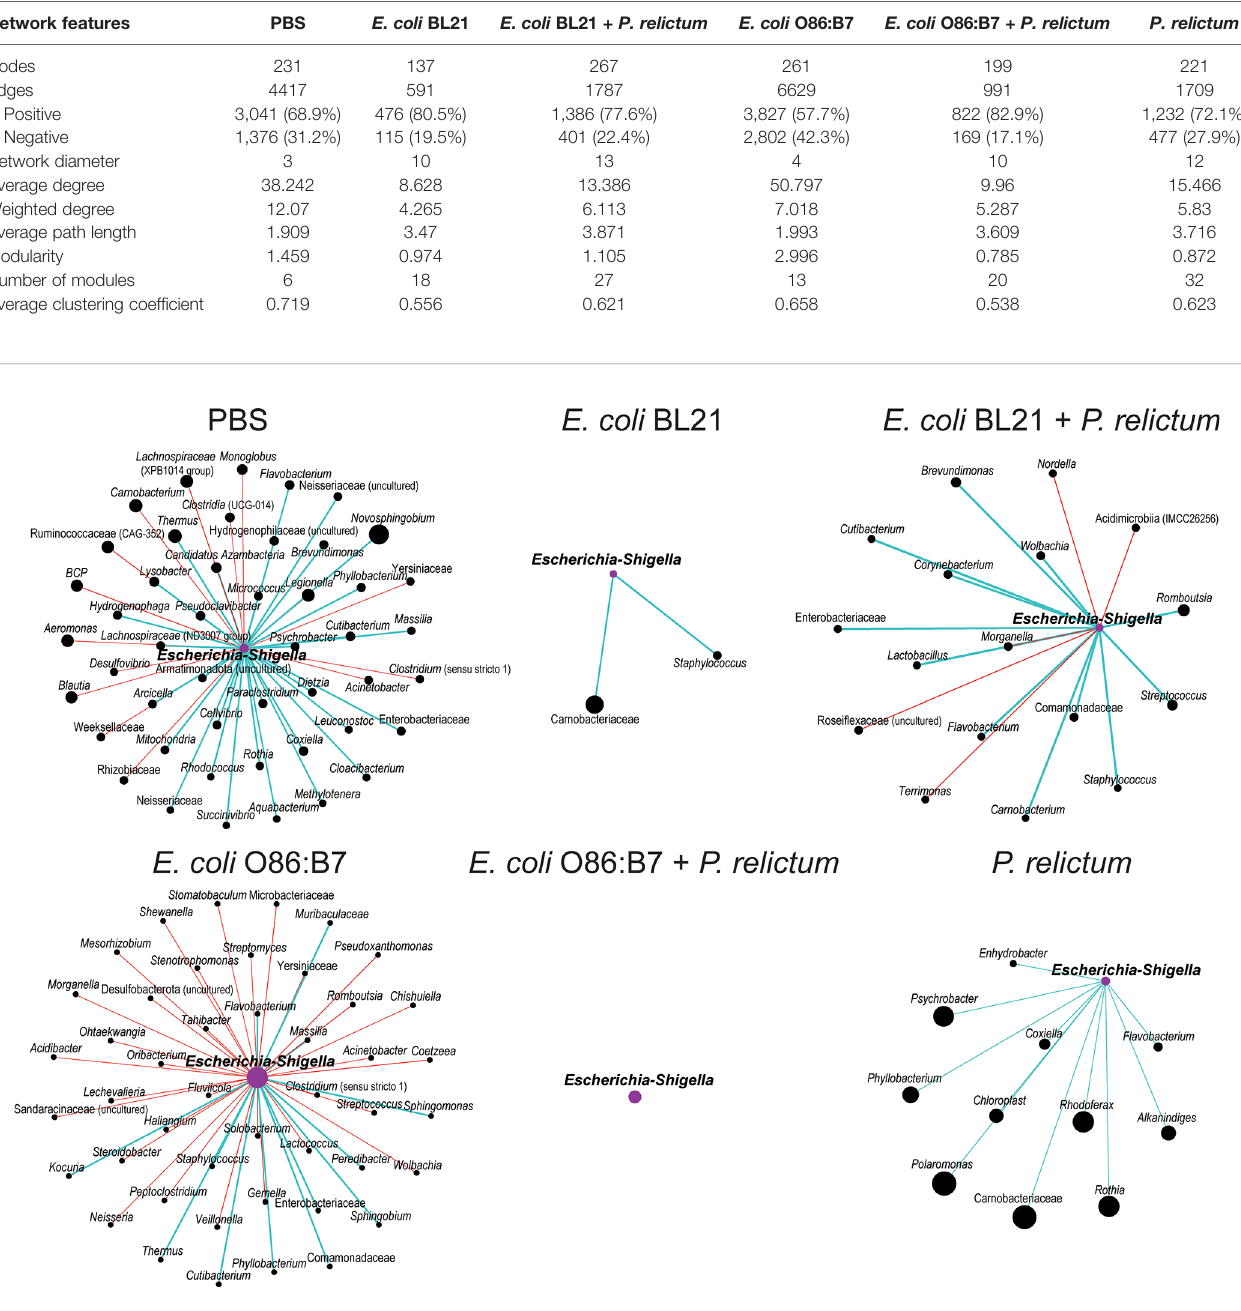
FIGURE 7 | Local connectivity of Escherichia-Shigella in the co-occurrence networks of C. quinquefasciatus microbiota in the different experimental groups. The nodes/taxa linked to Escherichia - Shigella (purple node) were identi fi ed in the bacterial co-occurrence networks of mosquitoes fed on mock-immunized (PBS), E. coli - immunized and infected birds. Node sizes are proportional to the eigenvector centrality value. Only nodes with at least one connection are displayed. Connecting edges stand for a co-occurrence correlation (SparCC > 0.75), representing positive (blue edges) and negative (red edges) interactions between bacteria. BCP – Burkholderia Caballeronia Paraburkholderia